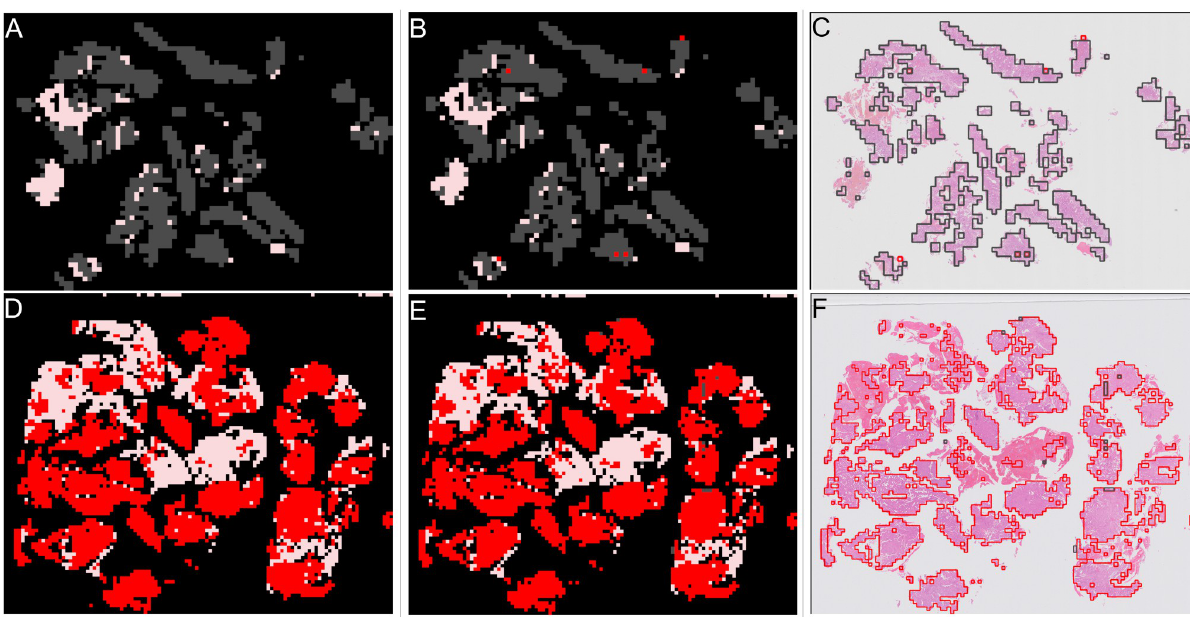
Fig 13. Examples of patch classifications for correctly predicted slides. Top row shows an “other or benign” slide from the validation set, bottom row shows a “malignant” slide from the validation set. First column shows annotation, second column shows model results, third column is model results overlaid on slide image. Red shows “malignant” patches. Grey shows “other or benign” patches. Pink shows “blood or mucus”. (A) Annotation of “other or benign” slide. (B) Patch results of “other or benign” slide. (C) Patch results overlaid on “other or benign” slide image. (D) Annotation of “malignant” slide. (E) Patch results of “malignant” slide. (F) Patch results overlaid on “malignant” slide